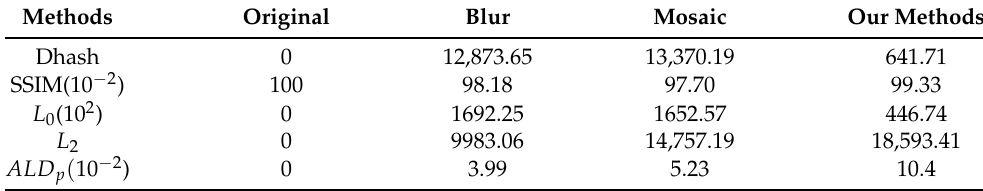
Table 1. Average result of 4000 street view images with the metrics: Dhash, SSIM, L 0 , L 2 , ALD p . Methods